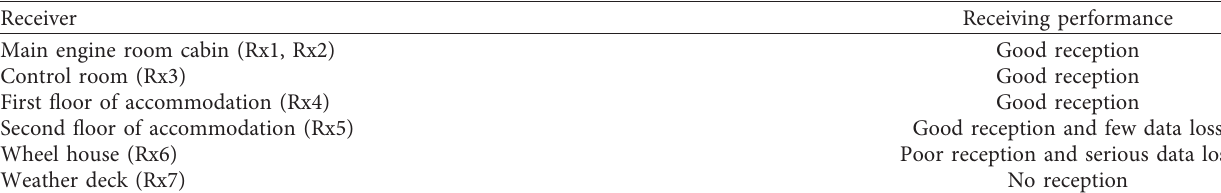
Table 2: Experimental results of the “Zhaoming”